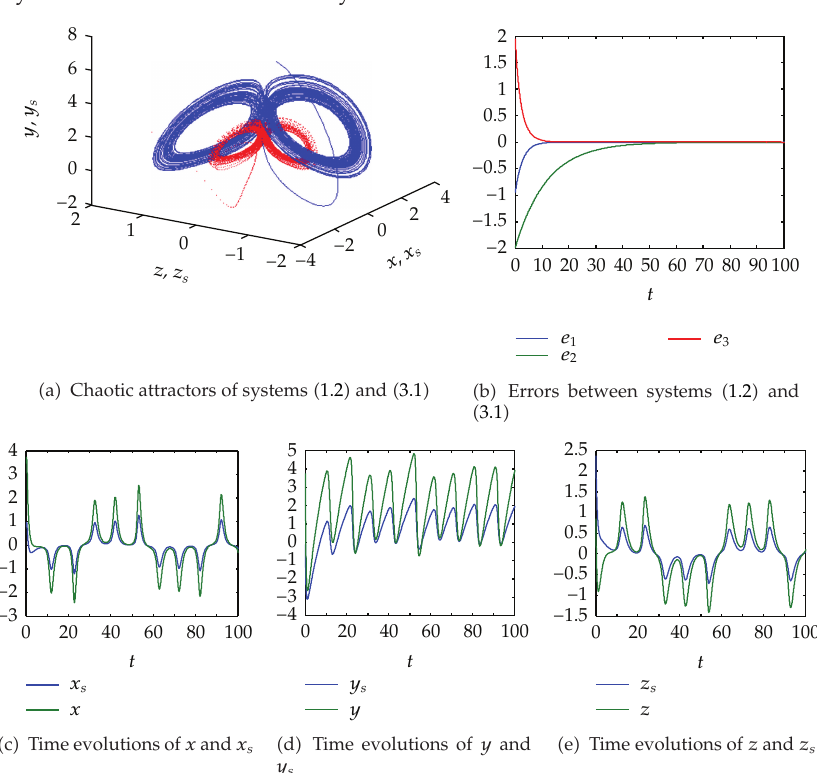
Figure 1: Synchronization errors between the master system (cid:7) 1.2 (cid:8) and the slave system (cid:7) 3.1 (cid:8) with a (cid:5) 1, (cid:5) 0 . 88, q (cid:5) 0 . 98, q (cid:5) 0 . 96, a (cid:5) 0 . 5, x (cid:7) 0 (cid:8) (cid:5) 3, y (cid:7) 0 (cid:8) (cid:5) 4, z (cid:7) 0 (cid:8) (cid:5) 1, x s (cid:7) 0 (cid:8) (cid:5) 0 . 5, y s (cid:7) 0 (cid:8) (cid:5) 0, b (cid:5) 0 . 1, c (cid:5) 1 . 2, q 1 2 3 z s (cid:7) 0 (cid:8) (cid:5) 2 .